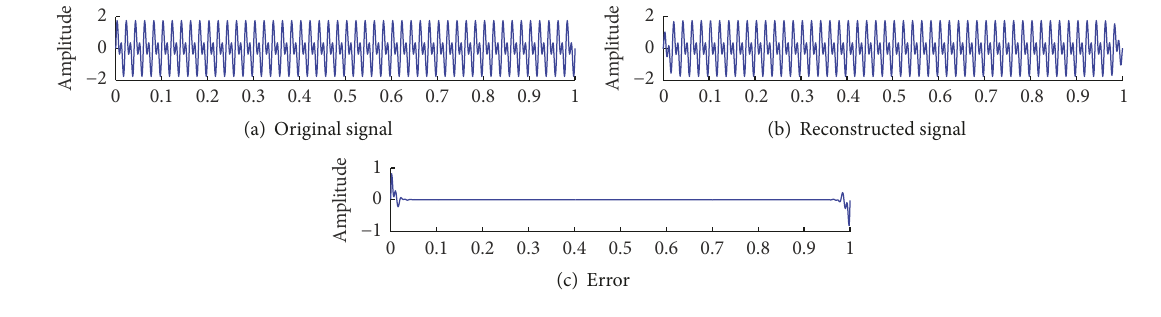
Figure 3: Reconfigurability of